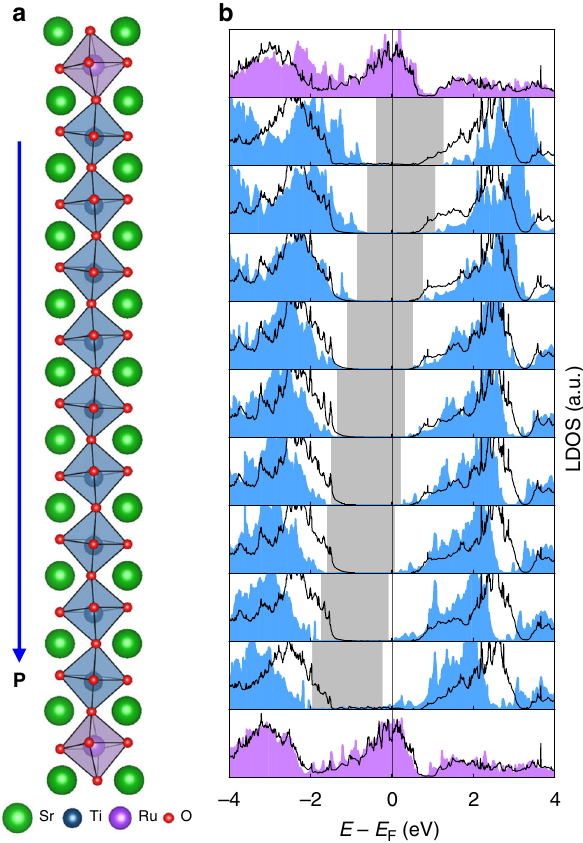
Fig. 3 Polarisation-induced local metallization in SrTiO 3 . a The simulation cell. We arti fi cially polarise SrTiO 3 (STO) layers with uniform displacement of Ti atom by 0.2 Å. b Calculated layer-resolved density of states (LDOS) of polarised STO layers ( fi lled blue) compared to that of nonpolar STO (black solid line). Grey regions represent a gap between conduction band minimum and valence band maximum of polarised STO layers, clearly showing a shift of energy bands due to polarisation-induced electric fi eld. Source data are provided as a Source Data fi